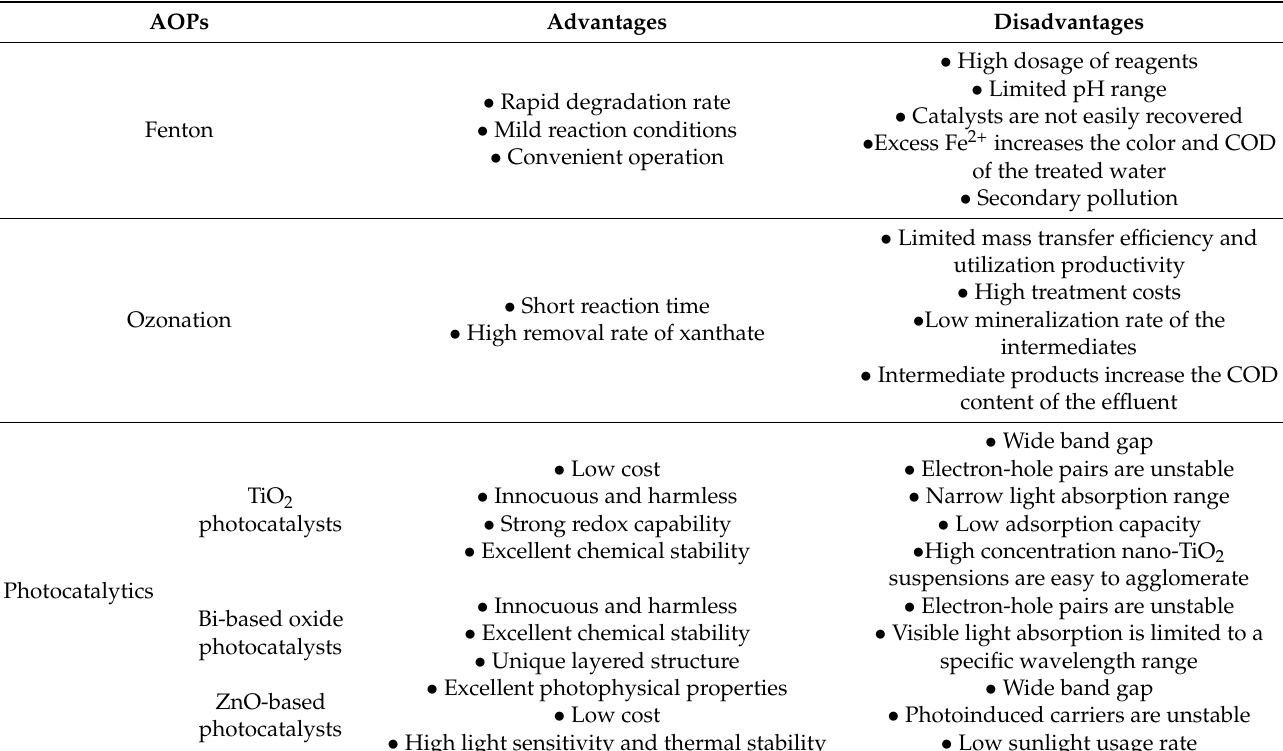
Table 1. The advantages and limitations of various